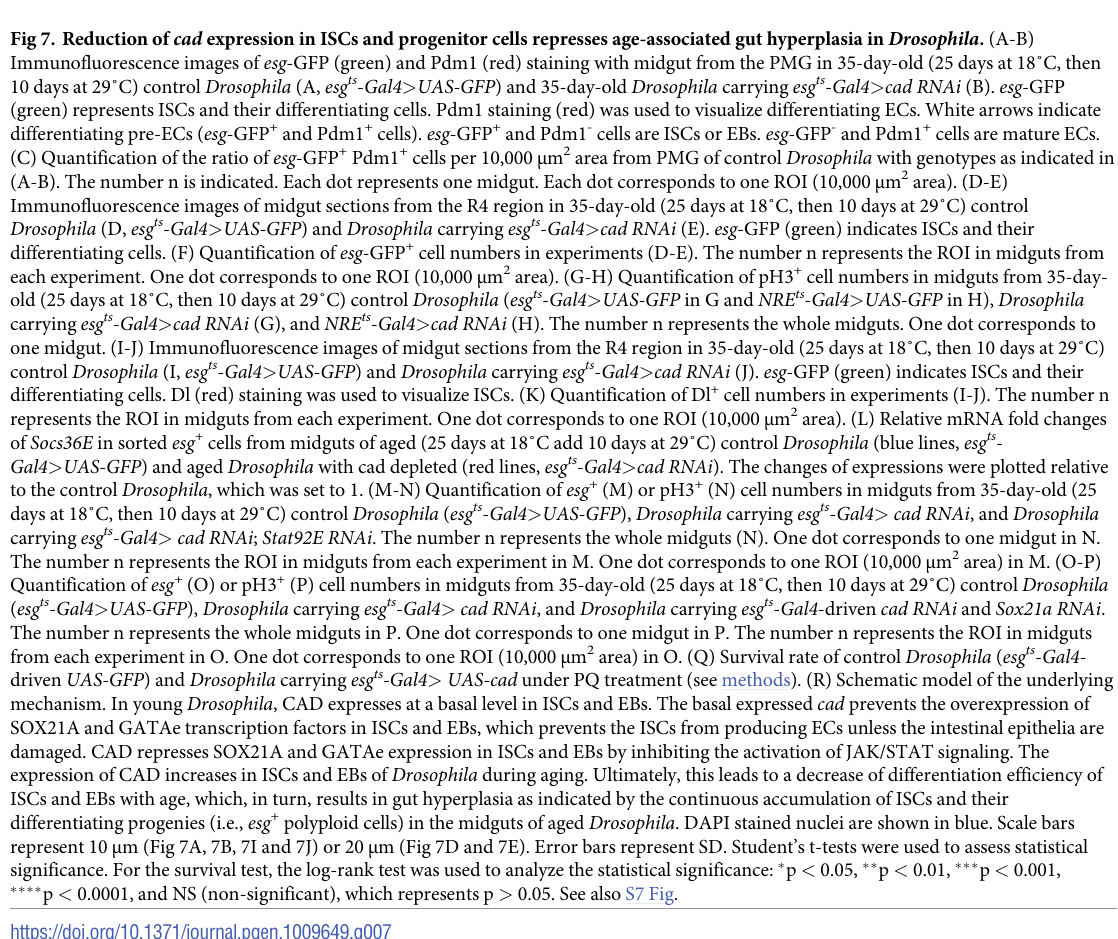
Fig 7. Reduction of cad expression in ISCs and progenitor cells represses age-associated gut hyperplasia in Drosophila . (A-B) Immunofluorescence images of esg -GFP (green) and Pdm1 (red) staining with midgut from the PMG in 35-day-old (25 days at 18˚C, then 10 days at 29˚C) control Drosophila (A, esg ts - Gal4 > UAS-GFP ) and 35-day-old Drosophila carrying esg ts - Gal4 > cad RNAi (B). esg -GFP (green) represents ISCs and their differentiating cells. Pdm1 staining (red) was used to visualize differentiating ECs. White arrows indicate differentiating pre-ECs ( esg -GFP + and Pdm1 + cells). esg -GFP + and Pdm1 - cells are ISCs or EBs. esg -GFP - and Pdm1 + cells are mature ECs. (C) Quantification of the ratio of esg -GFP + Pdm1 + cells per 10,000 μ m 2 area from PMG of control Drosophila with genotypes as indicated in (A-B). The number n is indicated. Each dot represents one midgut. Each dot corresponds to one ROI (10,000 μ m 2 area). (D-E) Immunofluorescence images of midgut sections from the R4 region in 35-day-old (25 days at 18˚C, then 10 days at 29˚C) control Drosophila (D, esg ts - Gal4 > UAS-GFP ) and Drosophila carrying esg ts - Gal4 > cad RNAi (E). esg -GFP (green) indicates ISCs and their differentiating cells. (F) Quantification of esg -GFP + cell numbers in experiments (D-E). The number n represents the ROI in midguts from each experiment. One dot corresponds to one ROI (10,000 μ m 2 area). (G-H) Quantification of pH3 + cell numbers in midguts from 35-day- old (25 days at 18˚C, then 10 days at 29˚C) control Drosophila ( esg ts - Gal4 > UAS-GFP in G and NRE ts - Gal4 > UAS-GFP in H), Drosophila carrying esg ts - Gal4 > cad RNAi (G), and NRE ts - Gal4 > cad RNAi (H). The number n represents the whole midguts. One dot corresponds to one midgut. (I-J) Immunofluorescence images of midgut sections from the R4 region in 35-day-old (25 days at 18˚C, then 10 days at 29˚C) control Drosophila (I, esg ts - Gal4 > UAS-GFP ) and Drosophila carrying esg ts - Gal4 > cad RNAi (J). esg -GFP (green) indicates ISCs and their differentiating cells. Dl (red) staining was used to visualize ISCs. (K) Quantification of Dl + cell numbers in experiments (I-J). The number